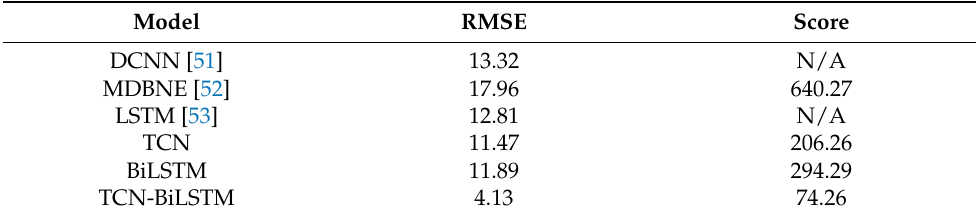
Table 5. Model RMSE and score results of the proposed method and related approaches.